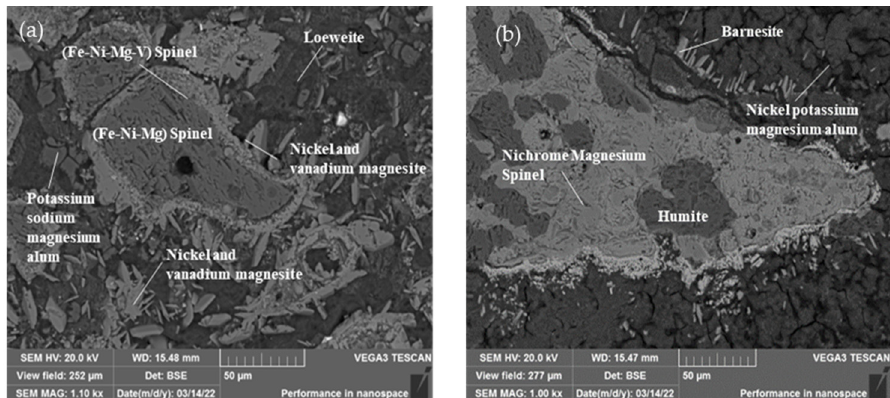
Figure 7. Nickel occurrence in the ore: ( a ) Scanning electron microscope image of nickel spinel in ore; ( b ) Scanning electron microscope image of minerals associated with nickel spinel.